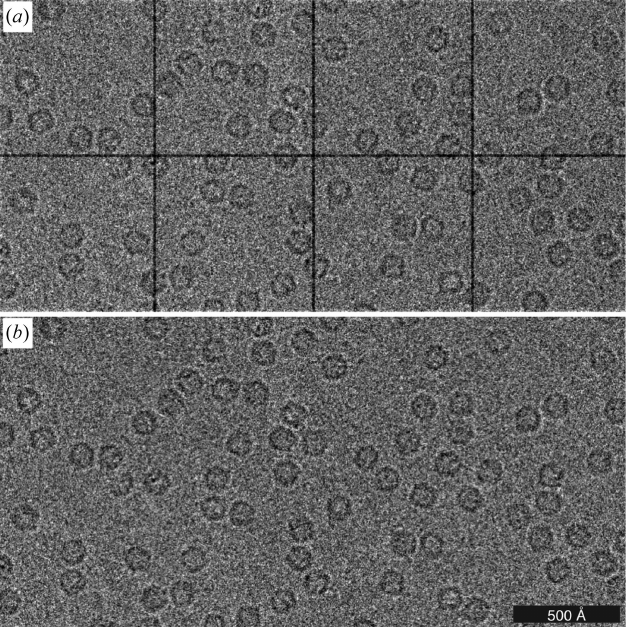
Figure 2 Example micrographs of apoferritin using 100 keVelectrons and a hybrid pixel detector (EIGER X 500 K). ( a ) The raw micrograph is separated into eight sectors corresponding to each of the ASIC modules with a two- pixel gap between them. ( b ) The gaps can be removed by gain correction, since the charge between the modules is collected in the neighbouring pixels.